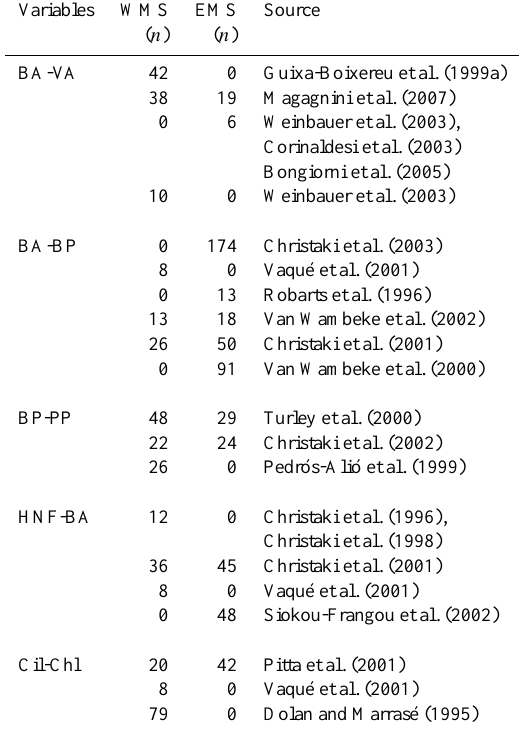
Table 4. Number ( n ) of data used to find out the relationships be- tween different variables in the Western Mediterranean (WMS) and the Eastern Mediterranean (EMS). BA: bacterial abundance; BP: Bacterial production; VA: viral abundance; PP: primary production; HNF: heterotrophic nanoflagellates abundance; Cil: ciliate abun- dances; Chl: chl a